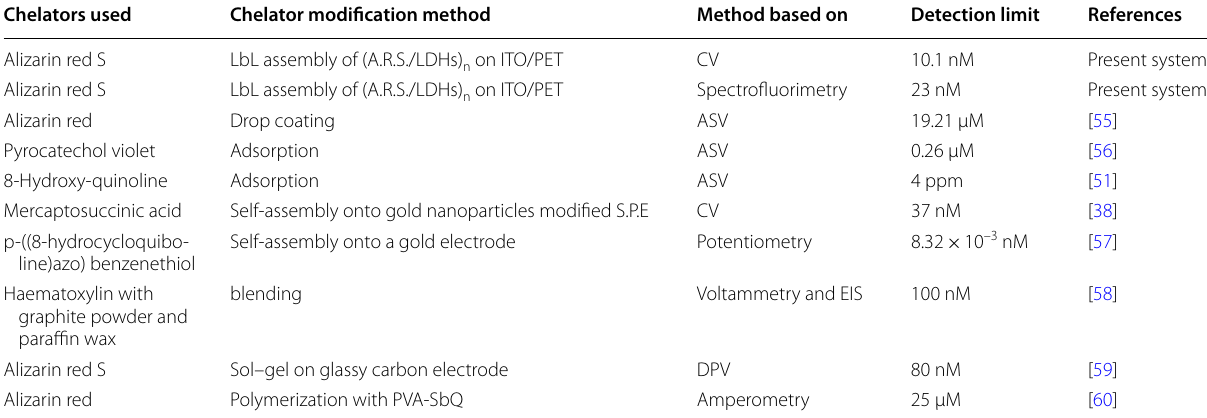
Table 3 Comparison of the present sensor system and other electrochemical Al 3 + detection methods Chelators